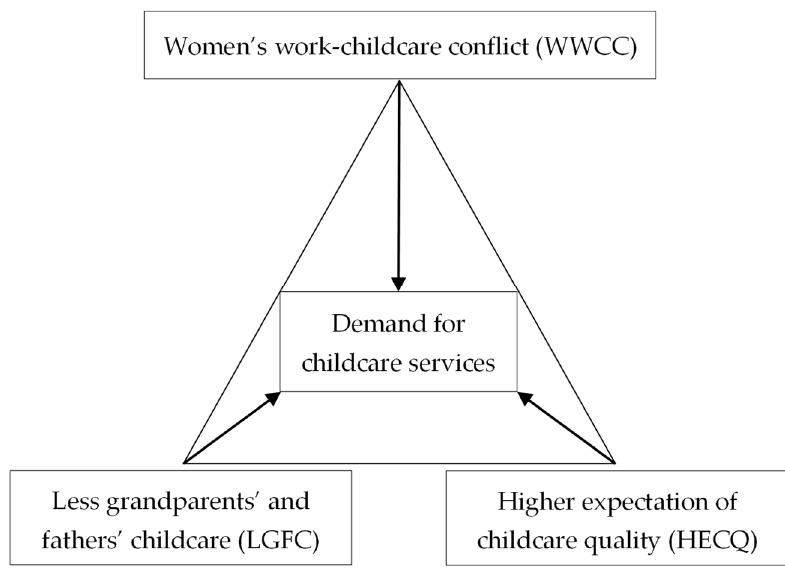
Figure 1. The Chinese context of family childcare for children under three.